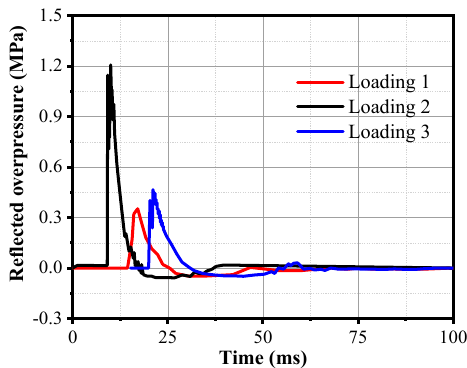
Figure 4. Stress-strain curves of SPUA at different strain rates.